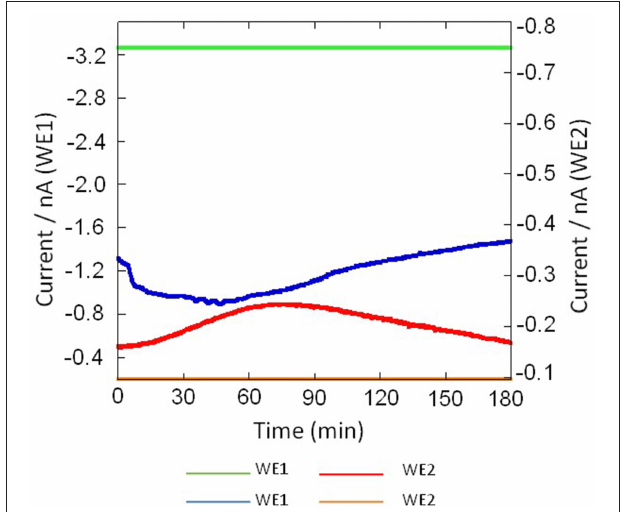
FIGURE 7 | Real-time monitoring of oxygen reduction current in system containing no THP-1 cell (green trace) and in THP-cell under the effect of 200 nM PMA (blue trace) were measured using Pt microelectrode (WE1) and real-time monitoring of reduction current for H 2 O 2 in system containing no THP-1 cell (yellow trace) and during respiratory burst in THP-1 (red trace) using Os-HRP modified Au electrode (WE2) under the effect of 200 nM PMA cells using a chip-type biosensor device.